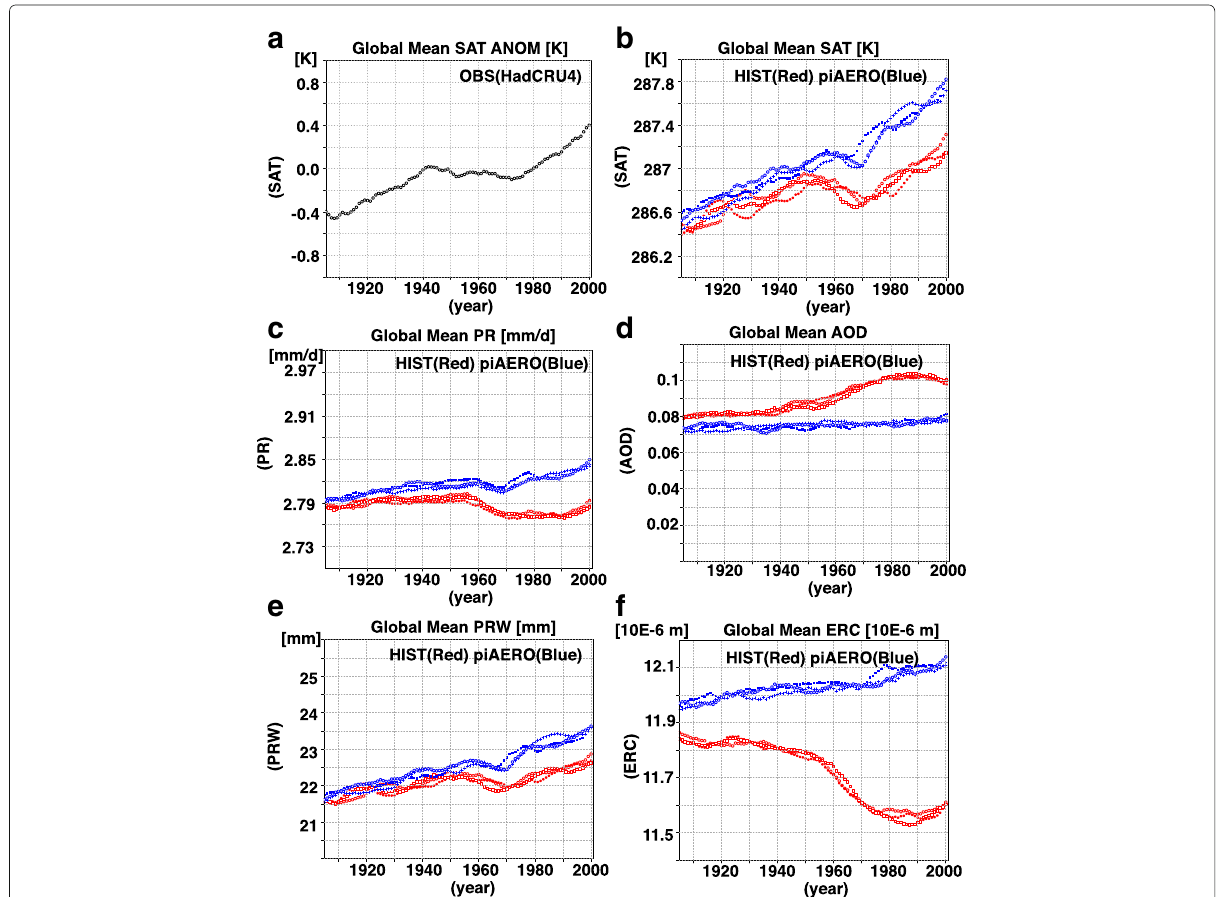
Fig. 1 a Observed time series of global mean surface air temperature (SAT) anomaly from the average of the period of 1961–1990. Simulated time series of the global mean b SAT, c precipitation, d aerosol optical depth (AOD), e precipitable water, and f effective radii of clouds in the three ensemble historical (HIST) and sensitivity (pre-industrial aerosol; piAERO) experiments. To examine the long-term trends, we used a 121-month running mean filter to remove seasonal and shorter interannual